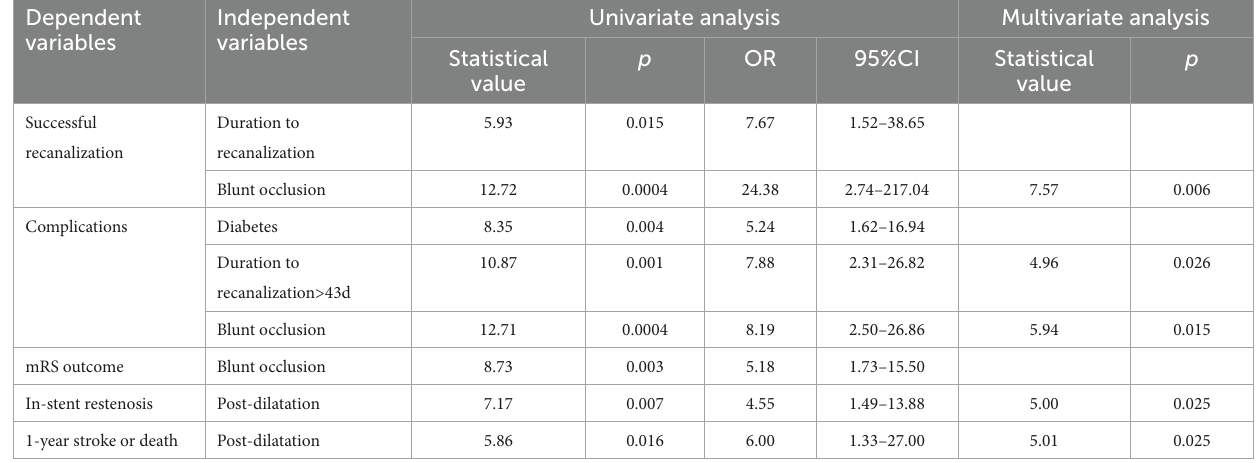
TABLE 4 Univariate and multivariate logistic analyses for risk